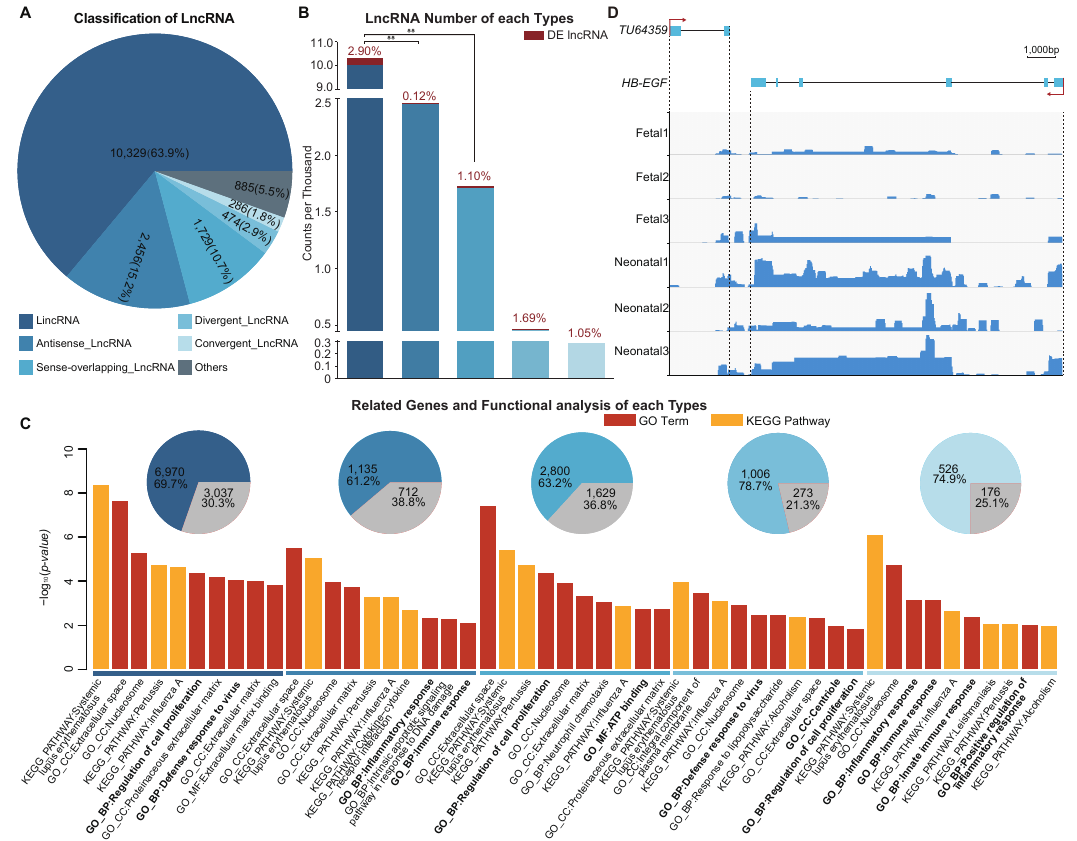
Figure 4. Classification and functional enrichment analysis of lncRNAs. ( A ) Classification of lncRNAs: proportion and number of each type is shown in the pipe plot; ( B ) lncRNA number for the different types: bars represent the counts for different types, DE lncRNAs numbers and ratios are labeled in red, χ -squared tests were performed on the counts between lincRNAs with other types. ( C ) Related genes and functional enrichment analysis of different lncRNA types: highly related genes for DE lncRNA of different types shown in pie plots (DE mRNAs are labeled in gray), top ten categories ( p < 0.05) are listed in bar plots after enrichment analysis by DAVID, DE mRNAs were set as gene list and all related genes as background. Categories related to cell proliferation, immune response and mitochondrial activation are in bold font; ( D ) Loci and expression levels of TU64359 and HB-EGF read abundance which was generated by integrative genomics viewer (IGV) v.2.4.10 [74]. **: p <